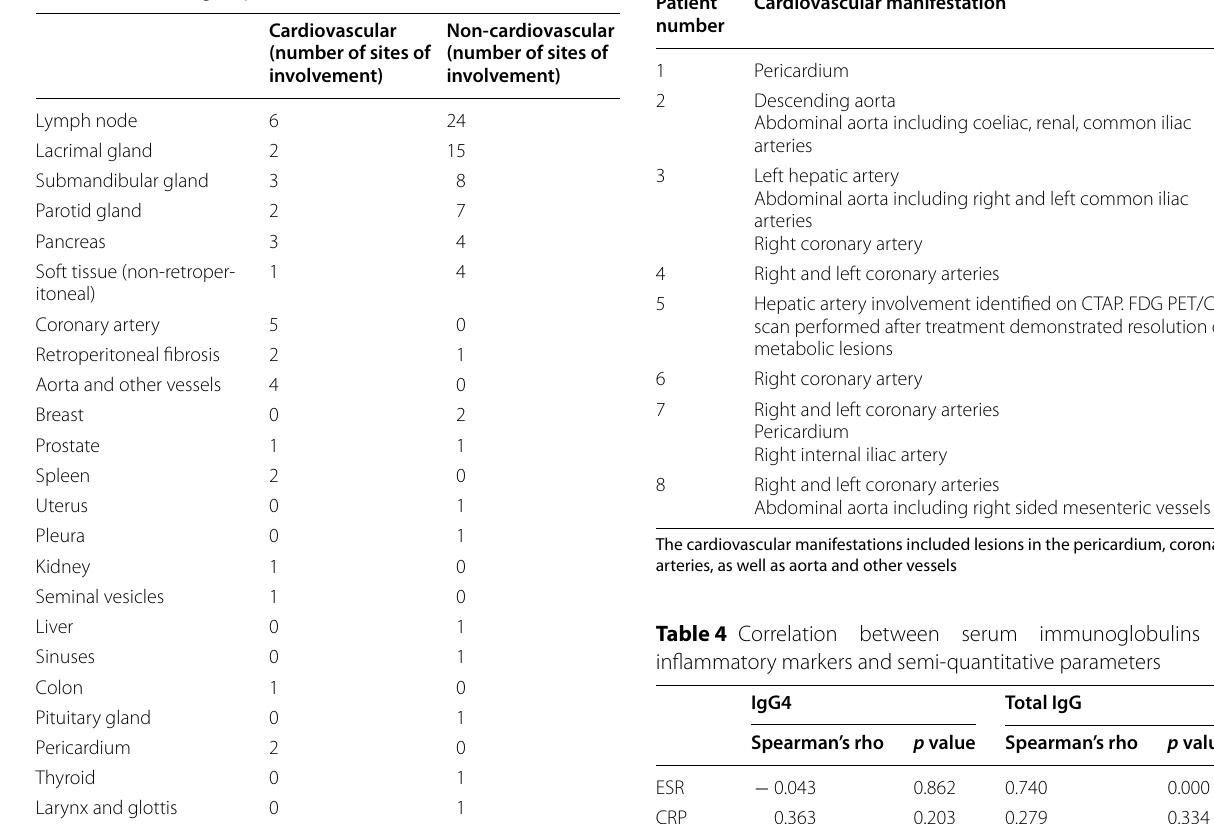
Table 2 Sites of disease involvement in cardiovascular and non‑ cardiovascular subgroup